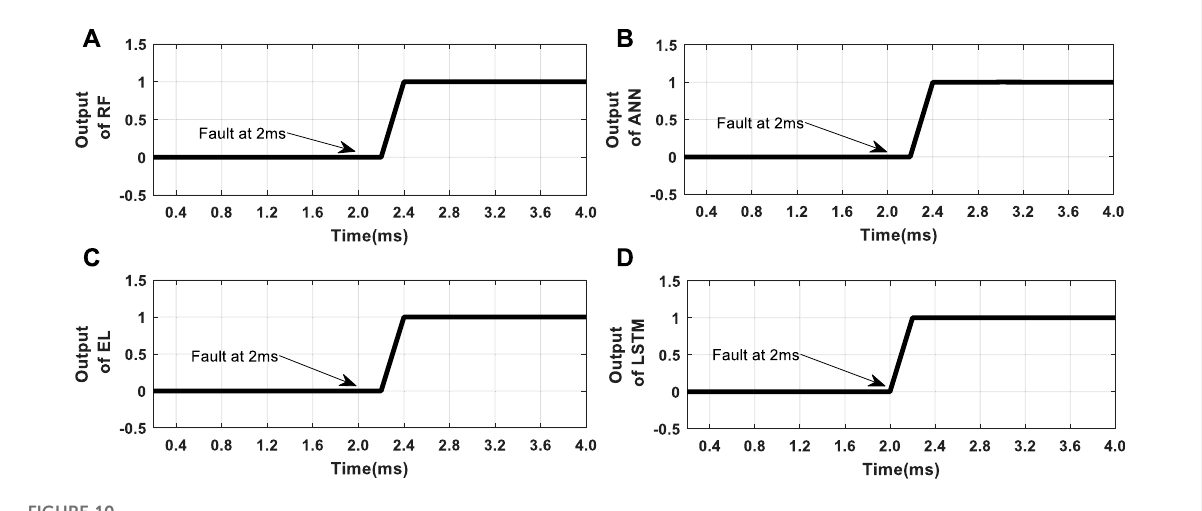
FIGURE 10 Fault detection output, (A) RF, (B) ANN, (C) EL, and (D) LSTM during P1G fault at 1,090 km with R = 100 Ω at 2 ms time.